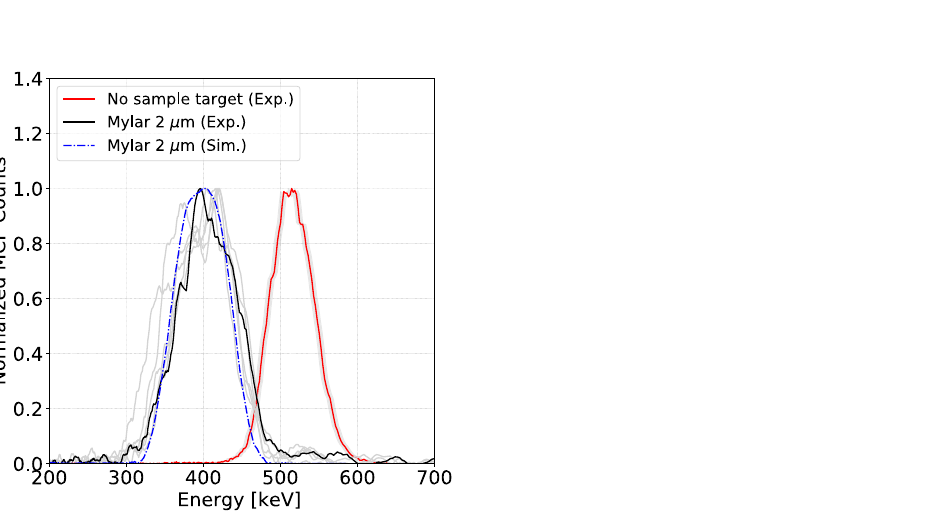
Table 2. Selected 500 keV proton beam bandwidth (FWHM) and spatial size as a function of the proton ∼ source size obtained with FLUKA MC simulations. The best fit to the experimental result is highlighted.